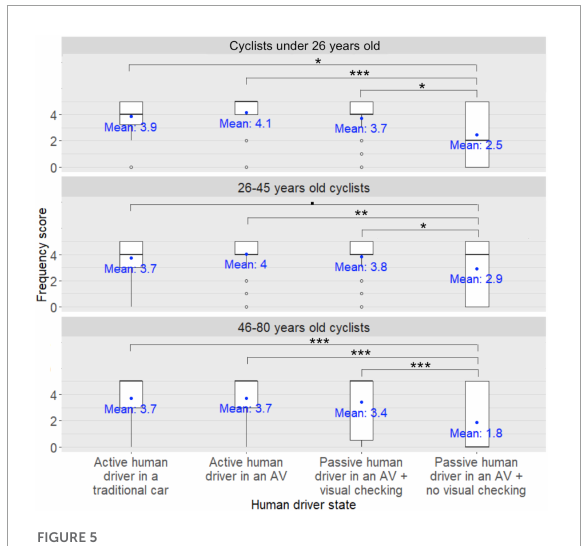
FIGURE5 Human driver state × participant’s age group interaction on the cyclists’ frequency scores for seeking eye contact with the human driver of the approaching car in order to express their willingness to cross to the human driver • : pFDR < 0.10, *: pFDR < 0.05, **: pFDR < 0.01, ***: pFDR <